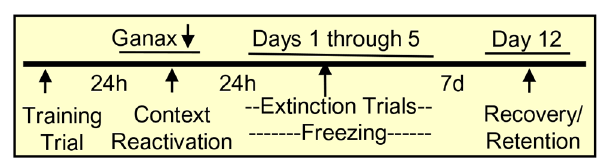
FIGURE 1 | Contextual fear conditioning protocol. Mice were trained in the conditioning chamber by tone plus footshock, which was repeated three times every 2 min.The total time in the conditioning chamber was 8 min.To induce retrieval/reactivation of the training memory, mice were placed in the conditioning chamber for 5 min and immediately after the reactivation session, they received a single injection of vehicle or ganaxolone. For the extinction trial (5 days), mice were placed in the chamber for 5 min without footshock, and freezing was measured as an indication of contextual fear. After an interval of 7 days (day 12), mice were reexposed to the chamber without footshock and freezing was measured as an indicator of the spontaneous reinstatement of contextual fear, or inversely, as extinction retention.